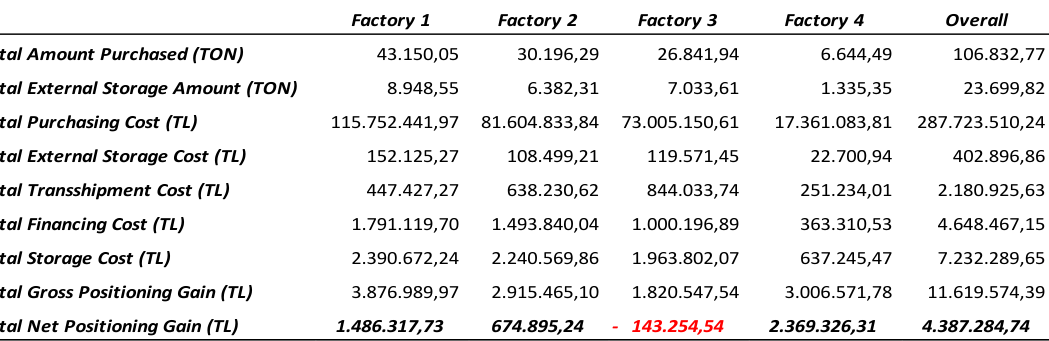
Table 6. Financial